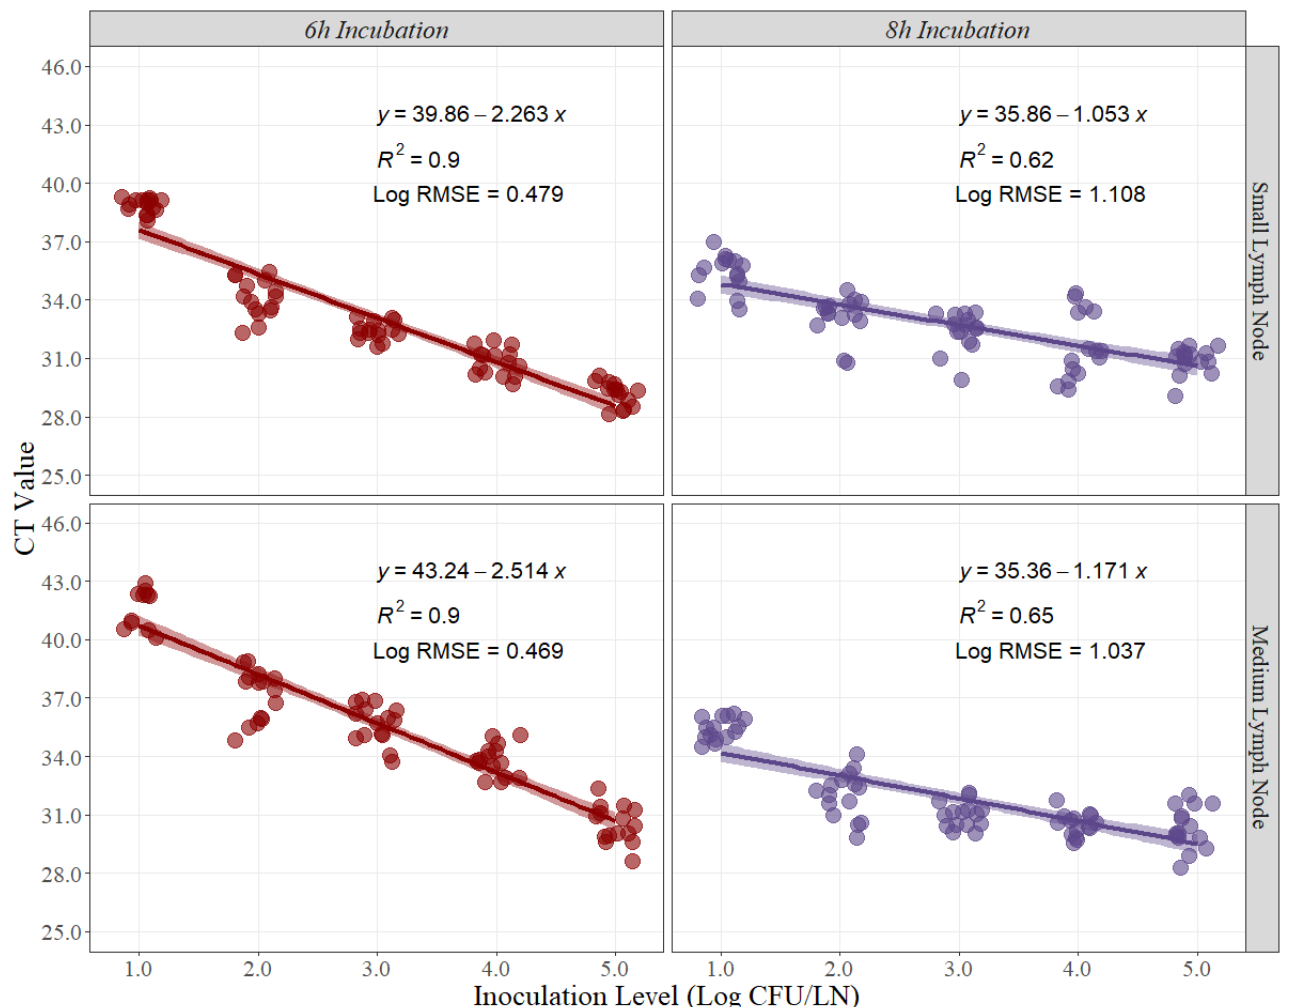
Figure 1. Linear regression for curve development of small and medium pork lymph nodes at 6 h and 8 h of recovery time, comparing cycle threshold (CT) values and inoculation levels (Log CFU/LN), (n = 15 per inoculation level). A small level of jittering was added to the actual dots for visualization purposes. RMSE = root mean squared error.